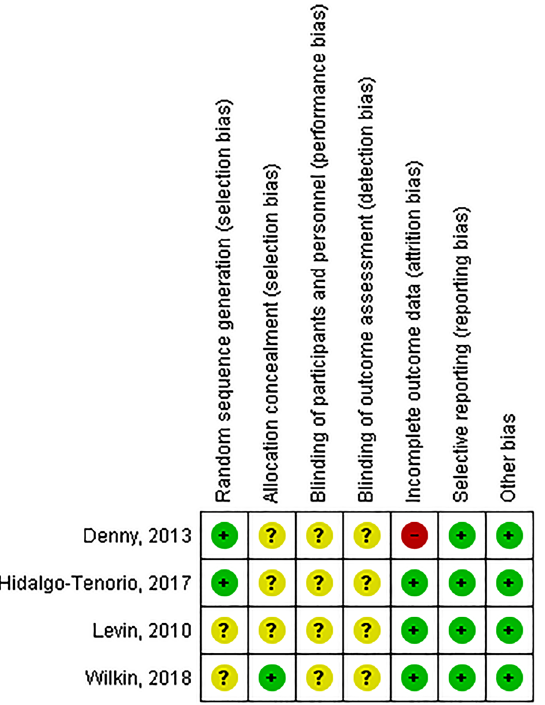
Figure 2. Risk of bias summary.